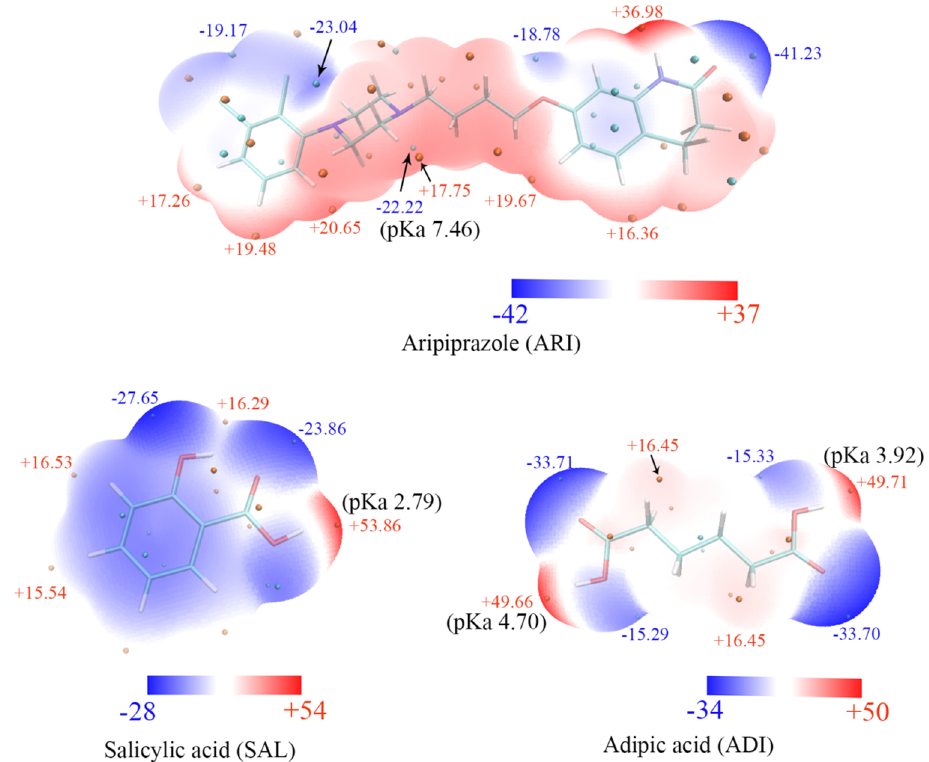
Figure 6. Electrostatic potential mapped onto the 0.001 a.u. electron density isosurface of ARI, SAL, and ADI. The maximal and minimal extreme points of electrical potential are marked with red and blue, repectively. The pKa values are presented in black.